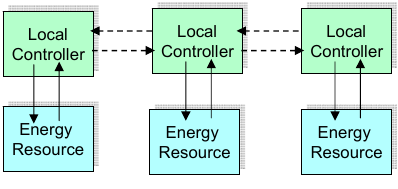
Figure 2. Local control structure.